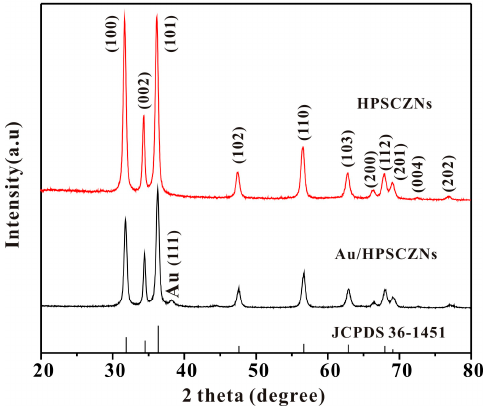
Figure 2. XRD patterns of the unmodified hierarchical porous single-crystalline ZnO nanosheets (HPSCZNs) (JCPDS 36-1451) and the Au-modified HPSCZNs.